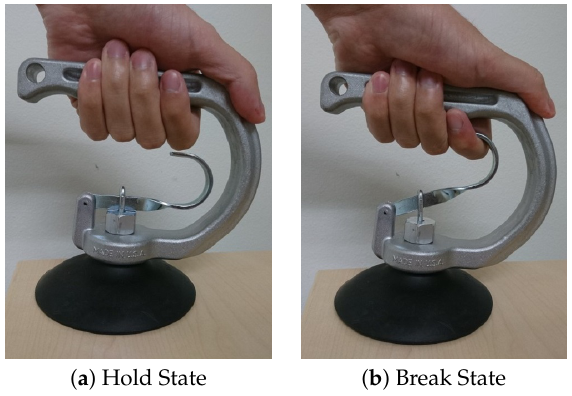
Figure 10. Handling of the suction cup. ( a ) Vacuum holding state; ( b ) vacuum breaking state. The suction is released by pulling the pin.